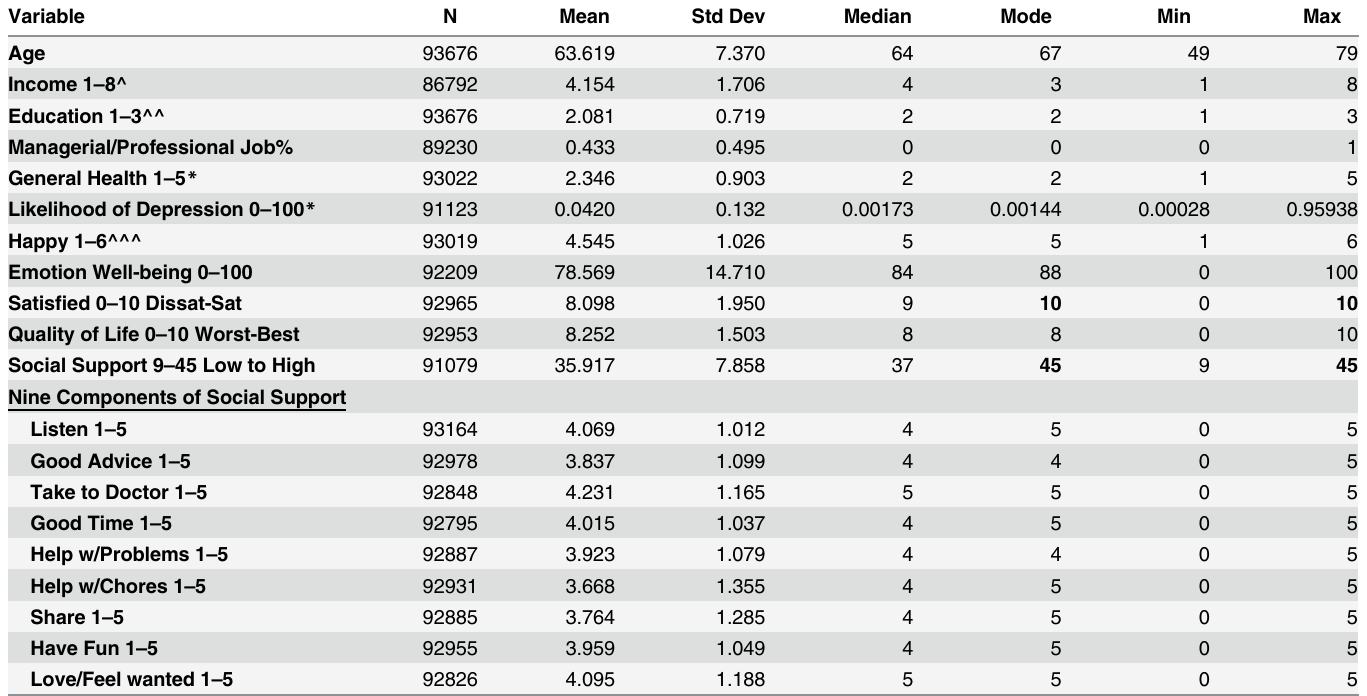
Table 1. Continuous Variable Descriptive